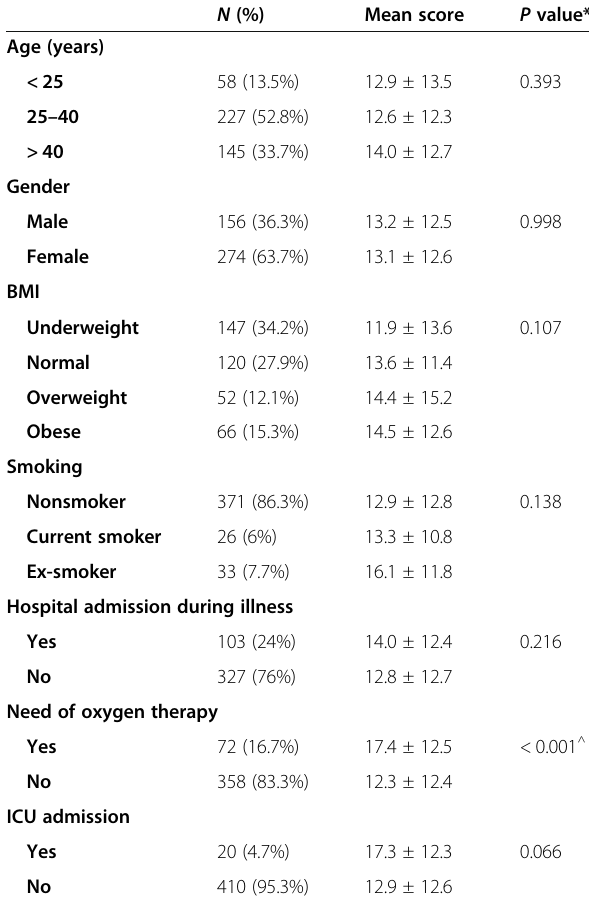
and symptom score in the included patients ( n =